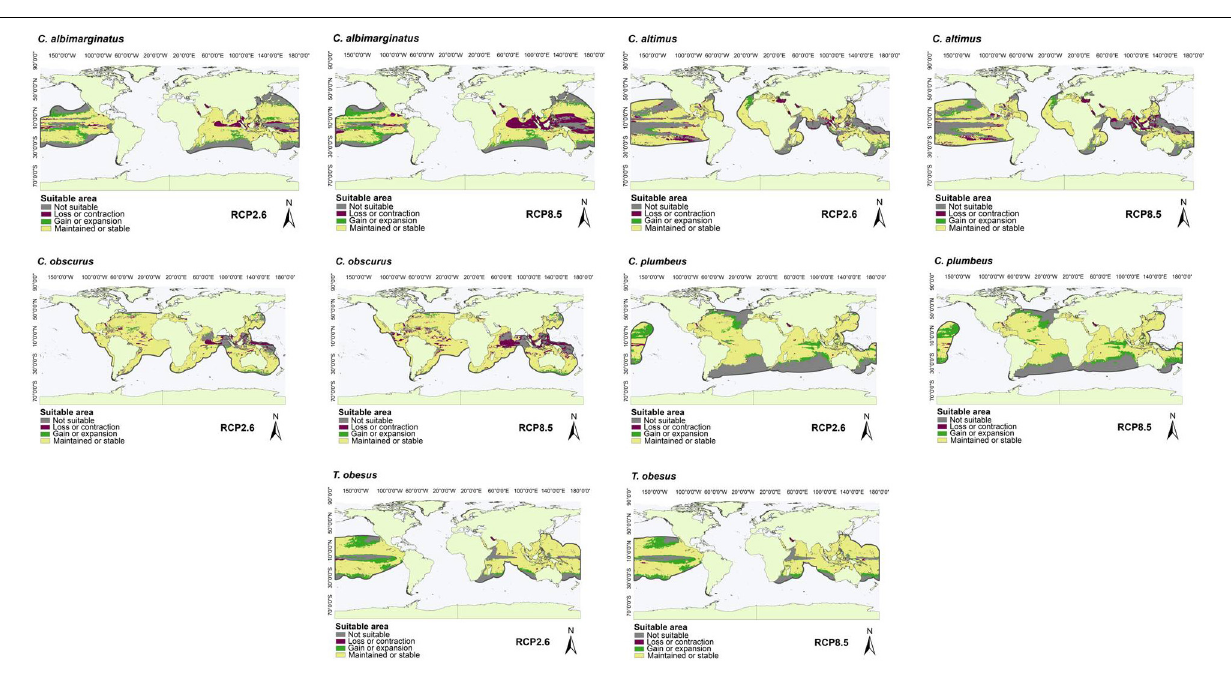
FIGURE 5 | Suitable areas maintained, gained, and lost by the year 2050 under low (RCP2.6) and high (RCP8.5) greenhouse gas emission scenarios in species with occurrence points outside of marine ecoregions and M areas in some regions of the Oceans (Atlantic, Pacific, and Indian), including the Mediterranean Sea: C. albimarginatus, C. altimus, C. obscurus, C. plumbeus, and T. obesus